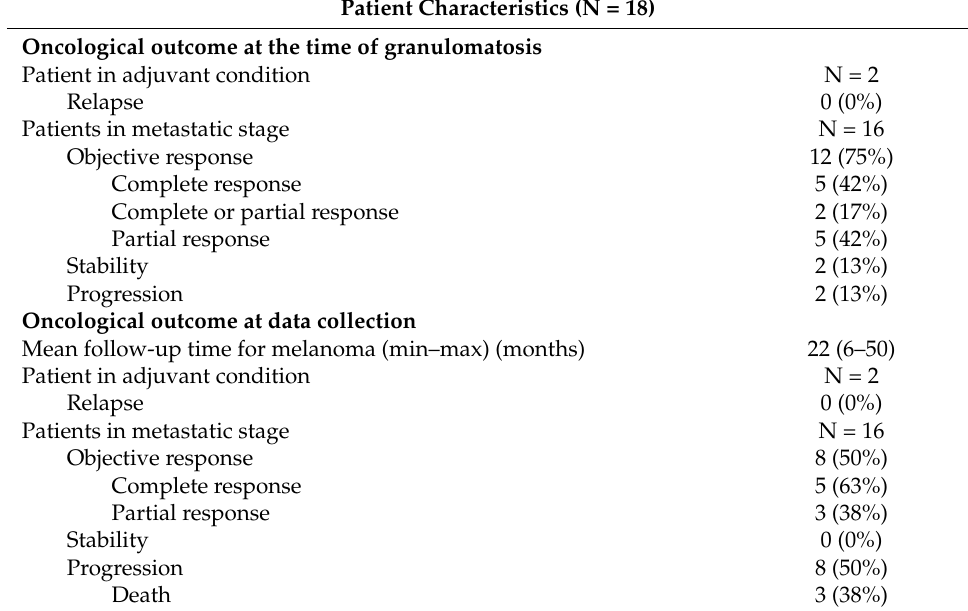
Patient Characteristics (N =